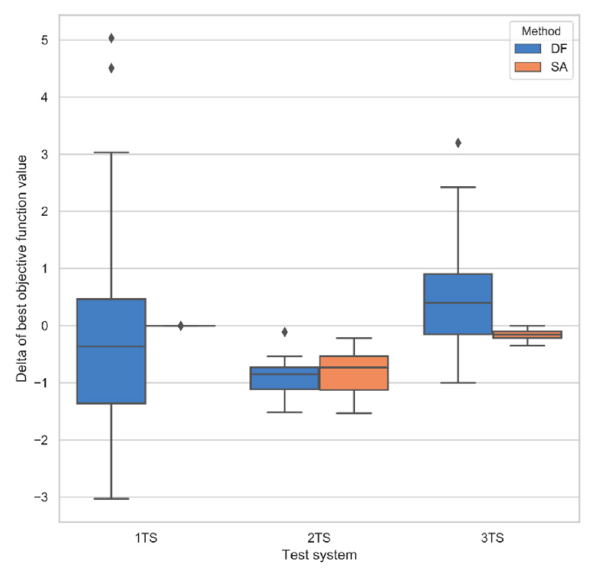
Figure 13. Boxplots for the resultant objective function value deviations from the initial points for the test cases under consideration calculated using the very fast simulated annealing (SA) and differential evolution (DF) methods.